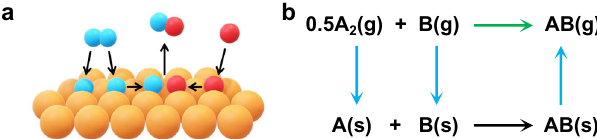
Fig. 1 | Accurate description for heterogeneous catalysis. Accurate descriptions of both the molecular and the extended system are essential for an accurate descriptionofthemolecule – metal-surfaceinteractionsinheterogeneouscatalysis. a The feature of metal-surface catalysis. The targets are to break some old bonds and to form some new bonds in the gas-phase molecular system (blue and red balls), while the metal surface (orange balls) assists such processes by stabilizing the intermediate molecular fragments (blue and red balls). b A Born – Haber cycle invoked in metal-surface catalysis. The gas-phase reaction (green) and the surface reaction (black) are related by the processes of adsorption and desorption